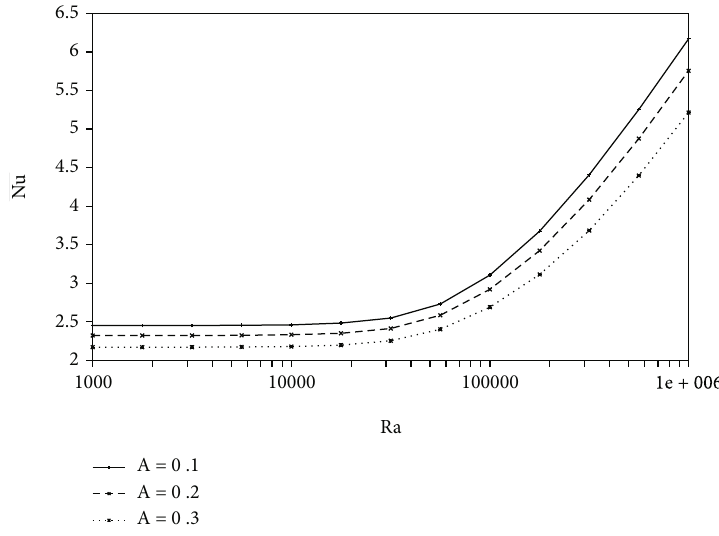
Figure 9: In fl uence of Rayleigh number and the corrugation amplitude on the average Nusselt number at N = 4 and ϕ = 0 : 03